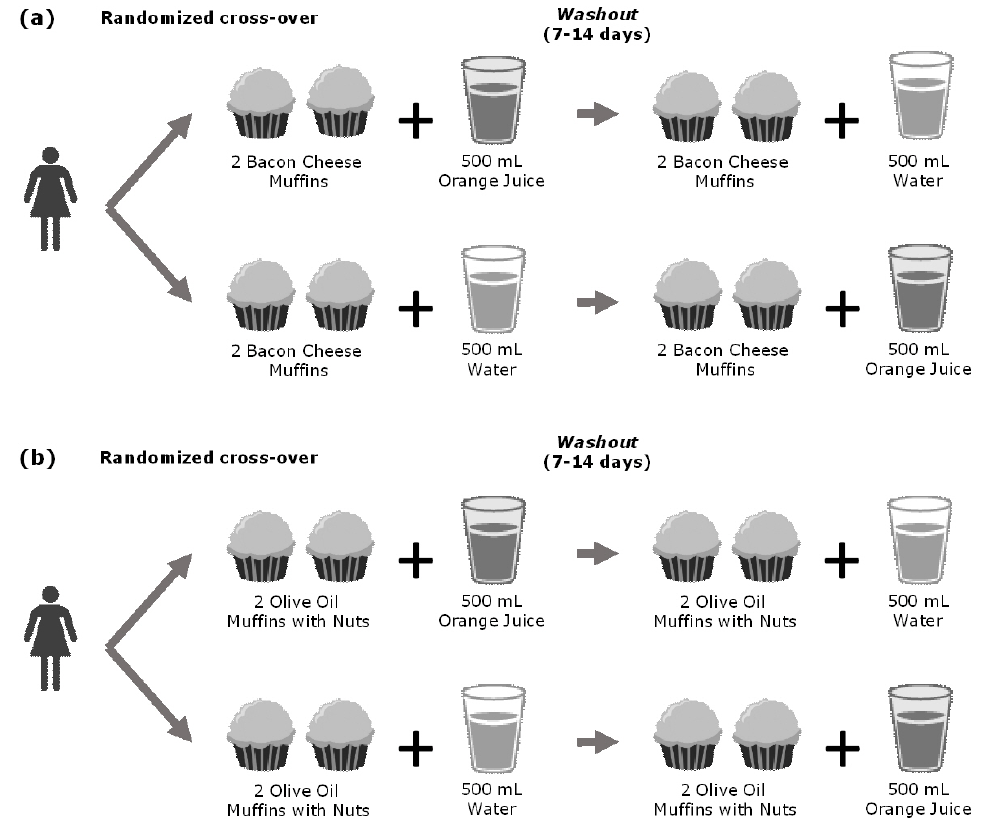
Figure 1. Schematic of study design. (a) Saturated Fat Acid high-fat meal group intervention: ≈1,000 kcal (14.6 Energy (E) % from carbohydrate, 6.2 E % from protein, 79.2 E % from fat – 37.6 E % from SFA); (b) Monounsaturated Fat Acid high-fat meal group intervention: ≈ 1,000 kcal (17.6 E% from carbohydrate, 4.2 E% from protein, 78.2 E% from fat – 56.3 E% from MUFA); Orange Juice: ≈ 230